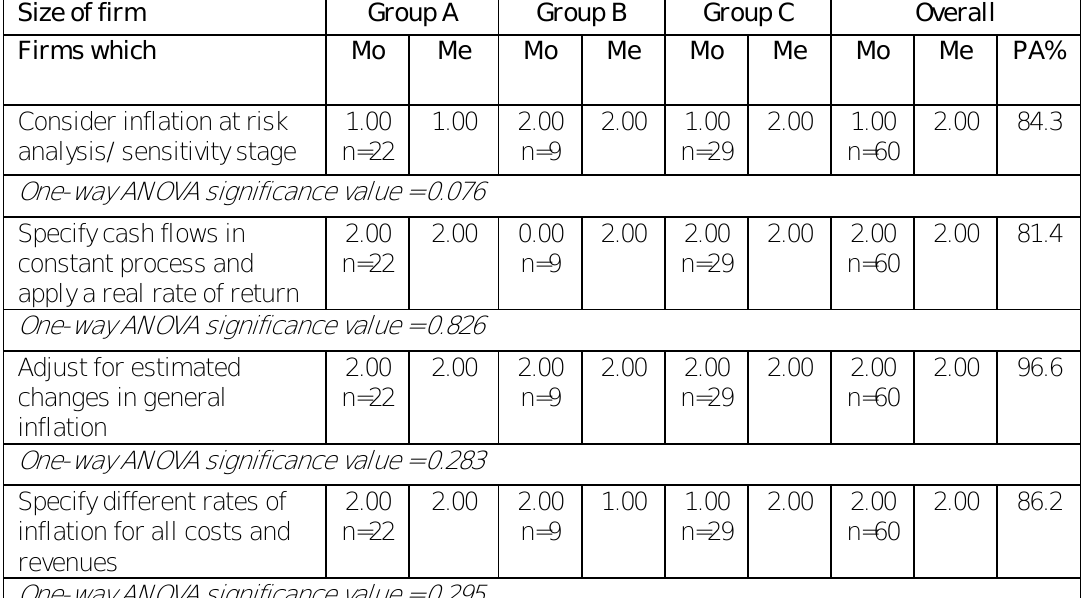
Table 6: Comparisons of the usage of methods for anticipating inflation Size of firm Group A Group B Group